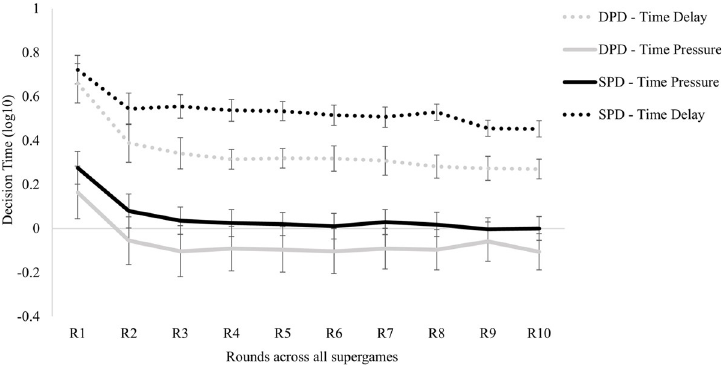
Fig 7. The average amount of decision time across the rounds played in all supergames. n = 28 participants in each condition presented. Error bars indicate standard errors of the mean.